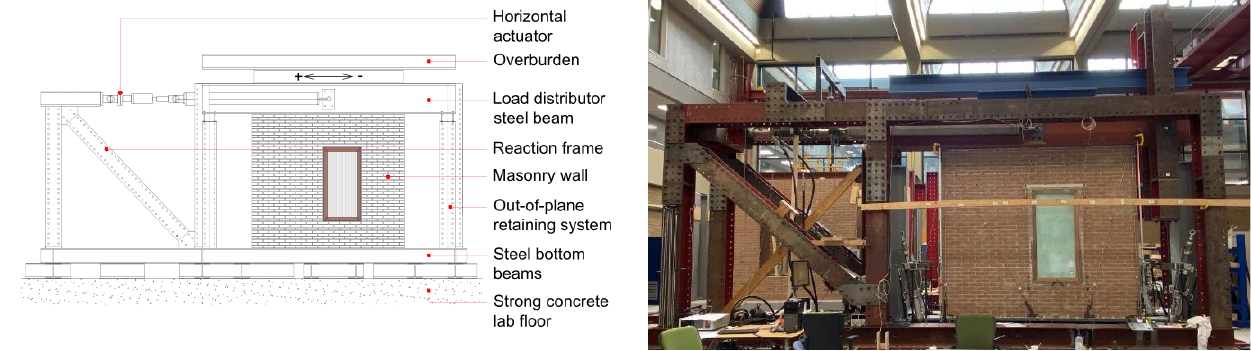
Figure 6. In-plane test set-up looking at the back of the wall (without DIC pattern).